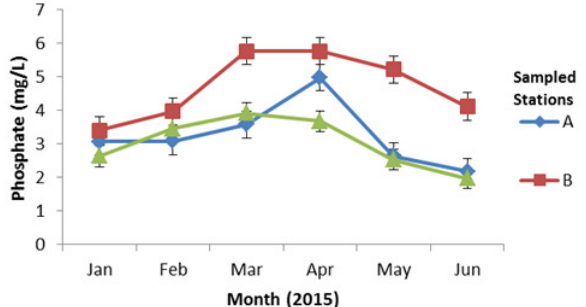
Fig. 11. The monthly mean variation in the phosphate (mg/L) levels of the water sampled from Saba River